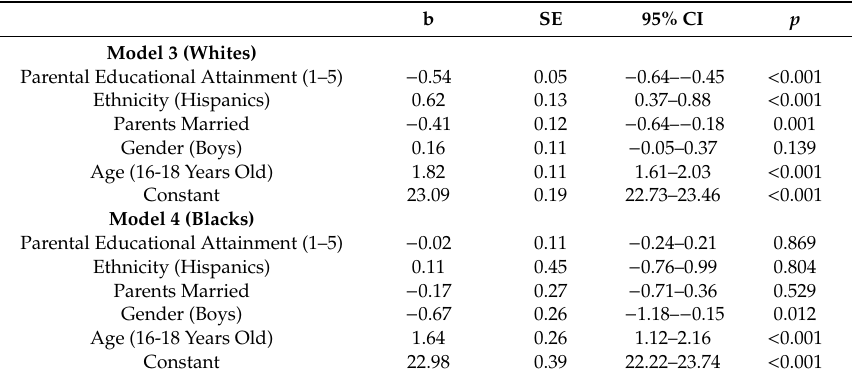
Table 3. Summary of linear regression models on body mass index (BMI) by race.